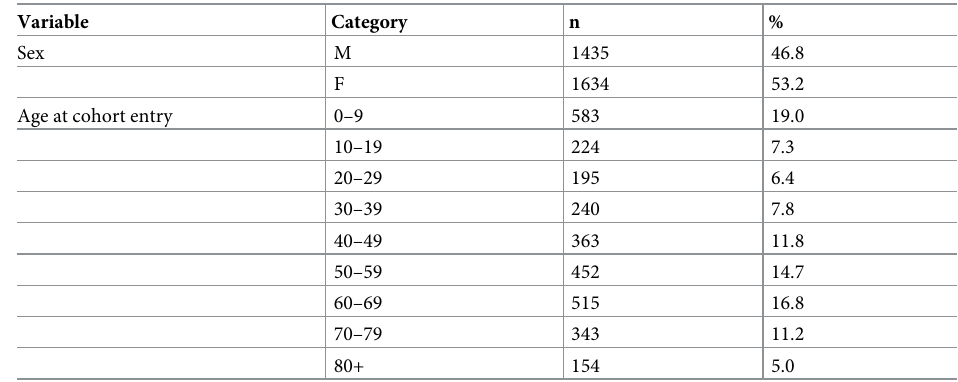
Table 1. Study cohort characteristics (n = 3069).